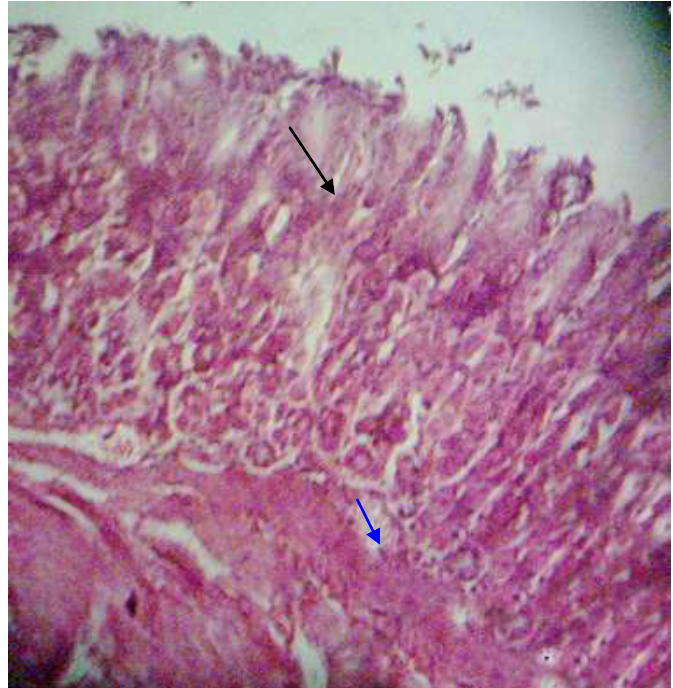
Figure (2): section of the intestine, showed hyperplasia, hypertrophy of the mucosa (  ) with sloughing of the epithelial cells, with infiltration of the inflammatory cells (  ).(H and E X